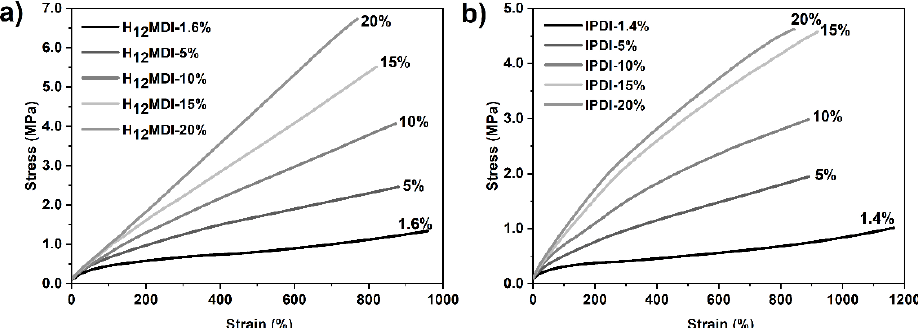
Figure 6. Representative stress–strain curves for PSU elastomers synthesized from ( a ) H 12 MDI and ( b ) IPDI with different HS contents. Young’s modulus (YM) for the PSUs increase with increasing HS content from approximately 1.4% to 20%, as is apparent by the steep increase of the slope within the linear ranges of the stress–strain curves. Regardless of their HS contents, all PSU elastomers are highly elastic and exhibited elongation at break values of over 800%.